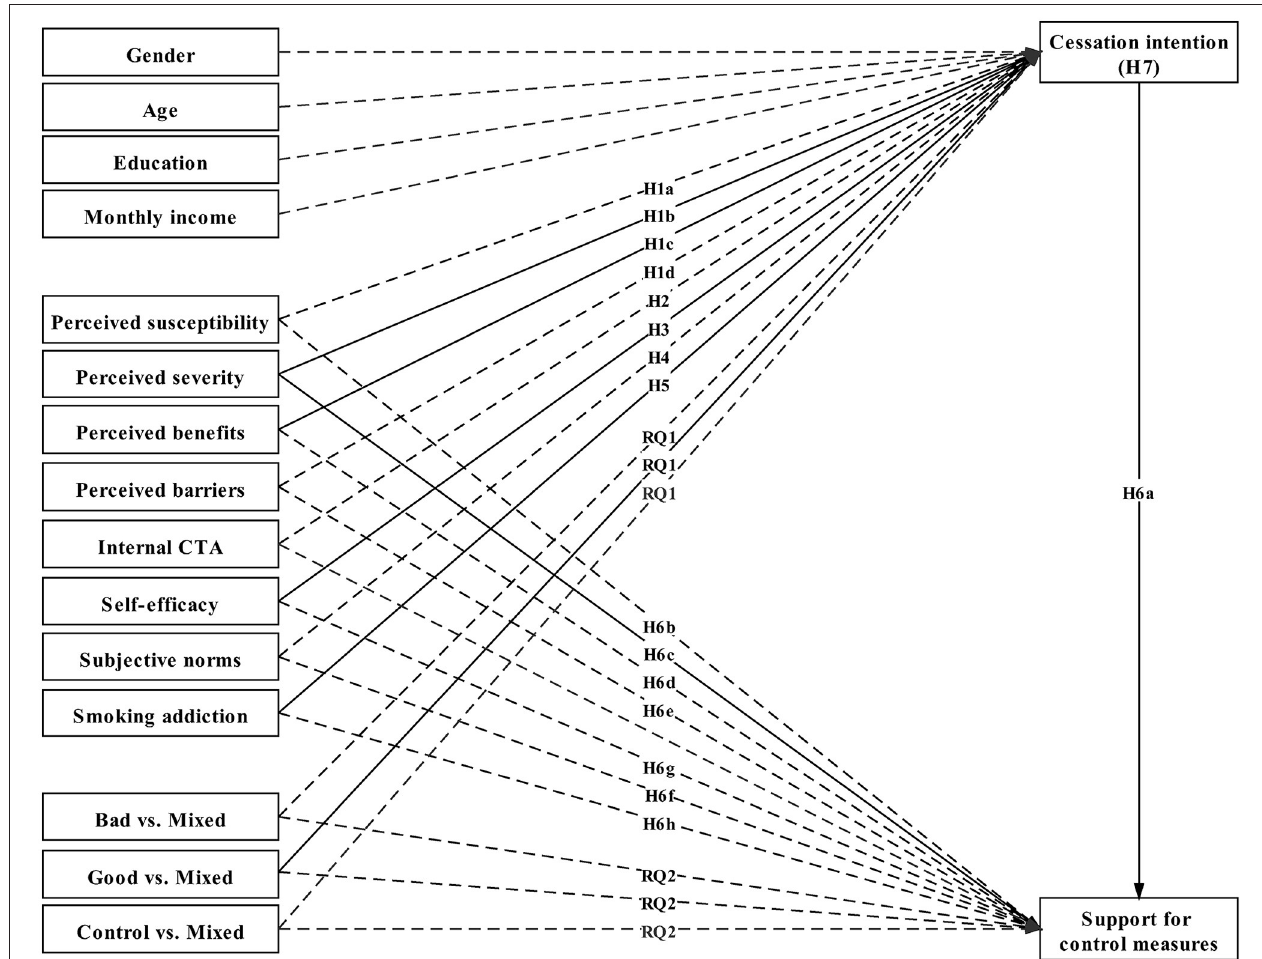
FIGURE 1 | Estimation results of the proposed model (Model